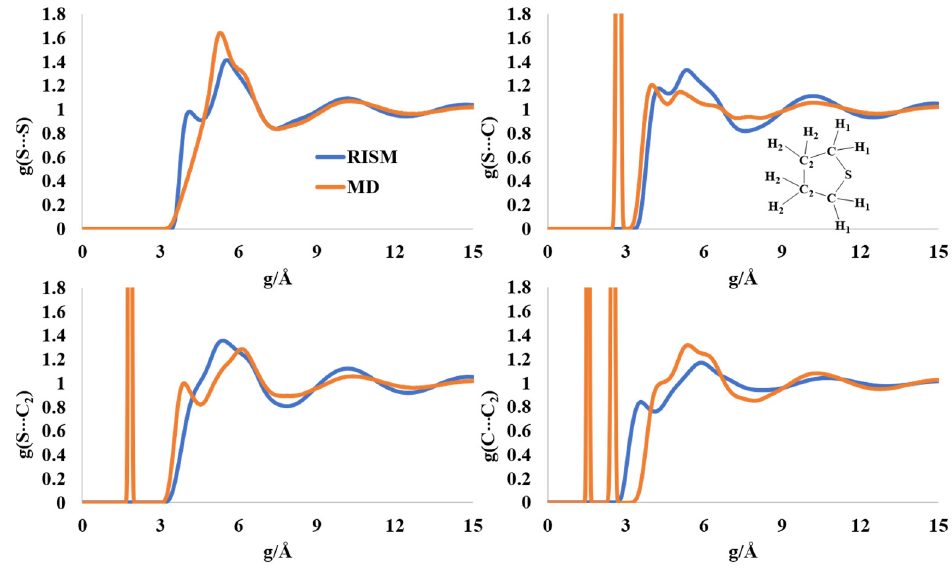
Figure 7. RISM- and MD-computed distribution functions for liquid thiolane.